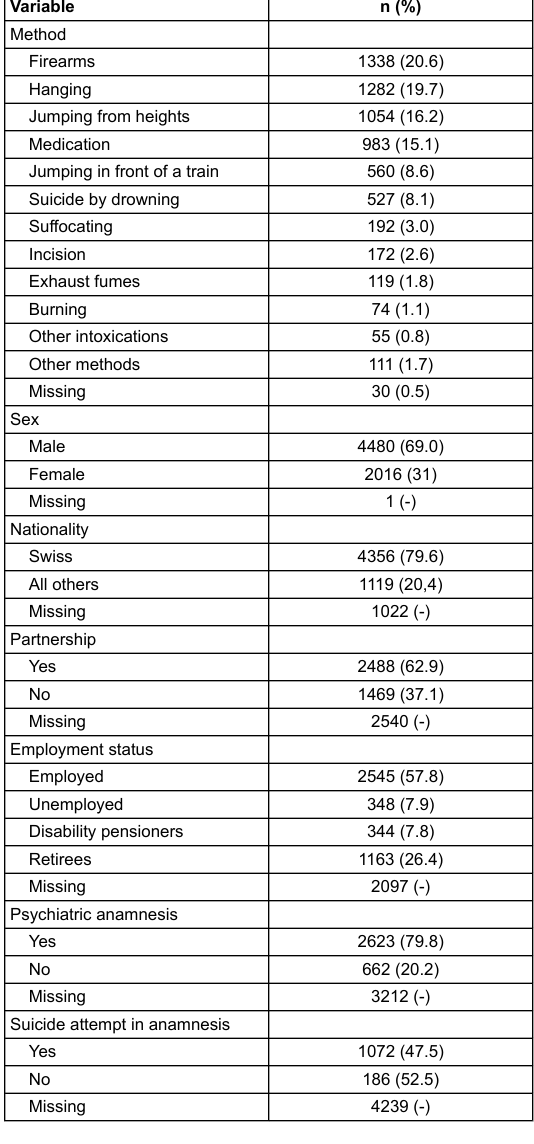
Table 1: Original study sample: all suicides in Switzerland between 2000 and 2010